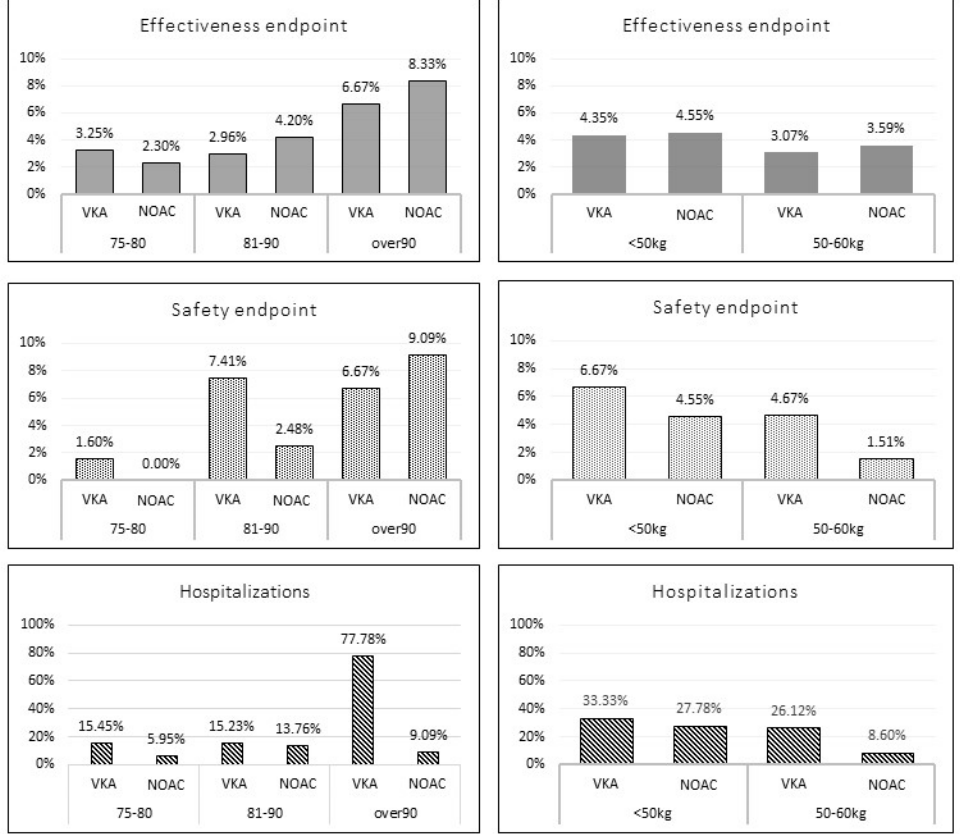
Figure 1. Incidence of the outcome events according to age and weight stratification among un- matched study population. VKA: vitamin K antagonist; NOAC: direct oral anticoagulant. Matched Population